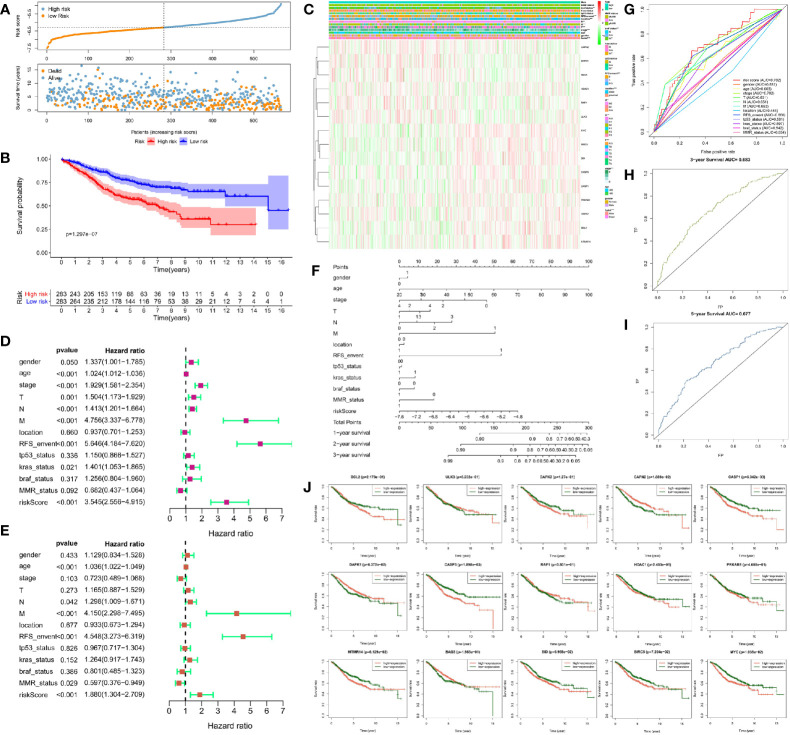
Risk prognosis model construction of 15 prognostic risk-related DEAGs in GEO data by unicox and Lasso regression. (A) The distribution of risk score and the scatterplot of the relationship between risk scores and survival time by R package “ggplot.” (B) Survival curve comparing high-risk and low-risk groups by R package “survival.” (C) Heat map of prognostic DEAGs and clinical parameters at high-risk and low-risk groups by R package “pheatmap.” (D) The univariate cox forest map of 13 clinical characteristics in the training set by R package “survival” and “forestplot.” (E) The multivariate cox forest plot of 13 clinical characteristics in the training set by R package “survival” and “forestplot.” (F) The nomogram baseline of multivariate cox analysis by R package “rms.” (G) ROC curve of risk sore and other clinical characteristics by R package “survivalROC.” (H) ROC curve of 3-year survival. (I) ROC curve of 5-year survival by R package “survivalROC.” (J) The survival curve of 15 prognostic risk-related DEAGs expression by R package “survival.” *P < 0.05, **P < 0.01, ***P < 0.001, and ****P < 0.0001.